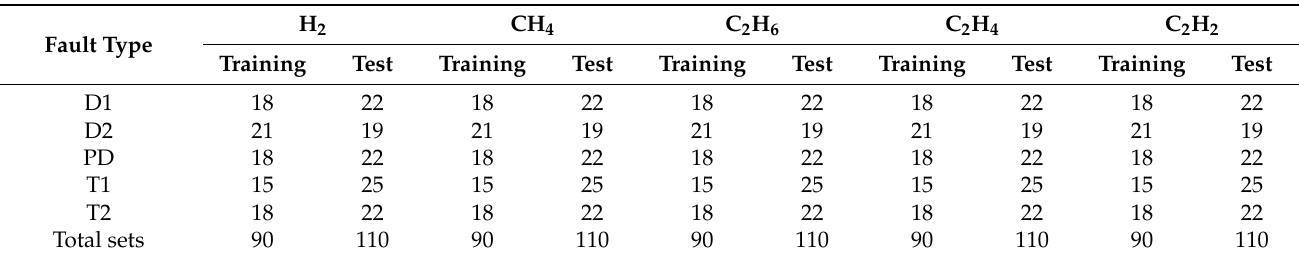
Table 1. Sample distribution of DGA